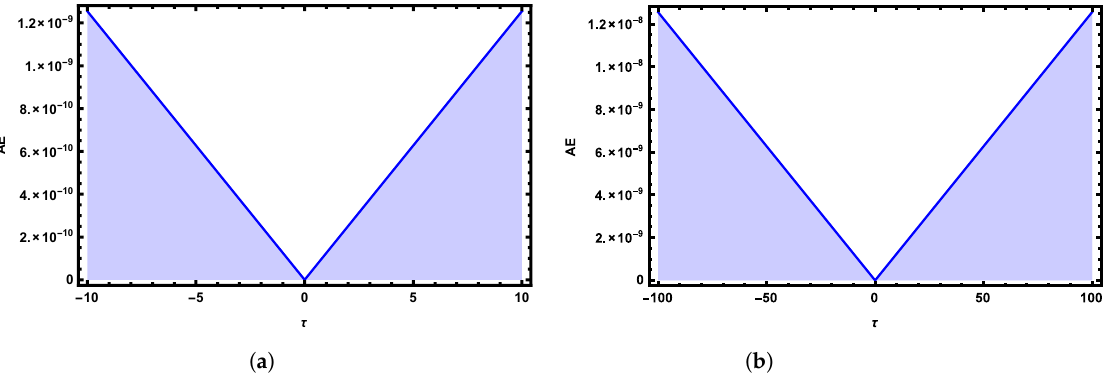
Figure 14. Absolute Error (AE) 2D graphs of obtained numerical solutions by using FNAM verses ( a ) τ ∈ [ − 10,10 ] and ( b ) τ ∈ [ − 100,100 ] at time ξ = 0.01 and a = c = 1 for Example 3. Comparisons between the exact and numerical solutions are plotted in Figure 16 by using the third terms of FNAM with τ ∈ [ − 10, 10 ] and τ ∈ [ − 100, 100 ] at ξ = 0.1 , k = 1 . The obtained numerical solutions at different values of α ’s with τ ∈ [ − 2, 2 ] and τ ∈ [ − 10, 10 ] at ξ = 0.1 and ξ = 0.2 are shown in Figure 17. In Figure 18, 3D plots of the exact and obtained results at τ ∈ [ − 10, 10 ] and ξ ∈ [ 0, 1 ] are plotted. Figure 19 shows the Absolute Error 2D graphs of the obtained result with τ ∈ [ − 10, 10 ] and τ ∈ [ − 100, 100 ] at ξ = 0.1 , k = 1 . A three- dimensional graph of the Absolute Error of the obtained numerical solution with τ ∈ [ − 10, 10 ] and τ ∈ [ − 100, 100 ] at ξ ∈ [ 0, 0.1 ] , k = 1 is illustrated in Figure 20.